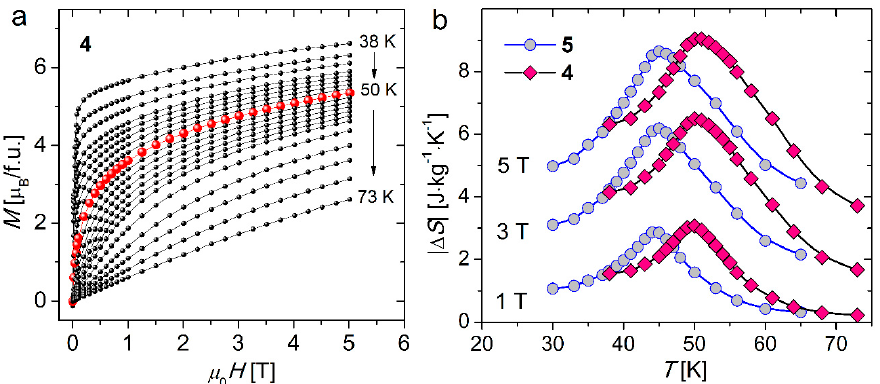
Figure 20. ( a ) Magnetization vs field isotherms measured in the vicinity of T c for {[Mn II (H 2 O) 2 ] 2 [Nb IV (CN) 8 ] · 4H 2 O} n ( 4 ) and ( b ) temperature dependence of magnetic entropy change recorded in various magnetic fields for ( 4 ) and {[Fe II (H 2 O) 2 ] 2 [Nb IV (CN) 8 ] · 4H 2 O} n ( 5 ).